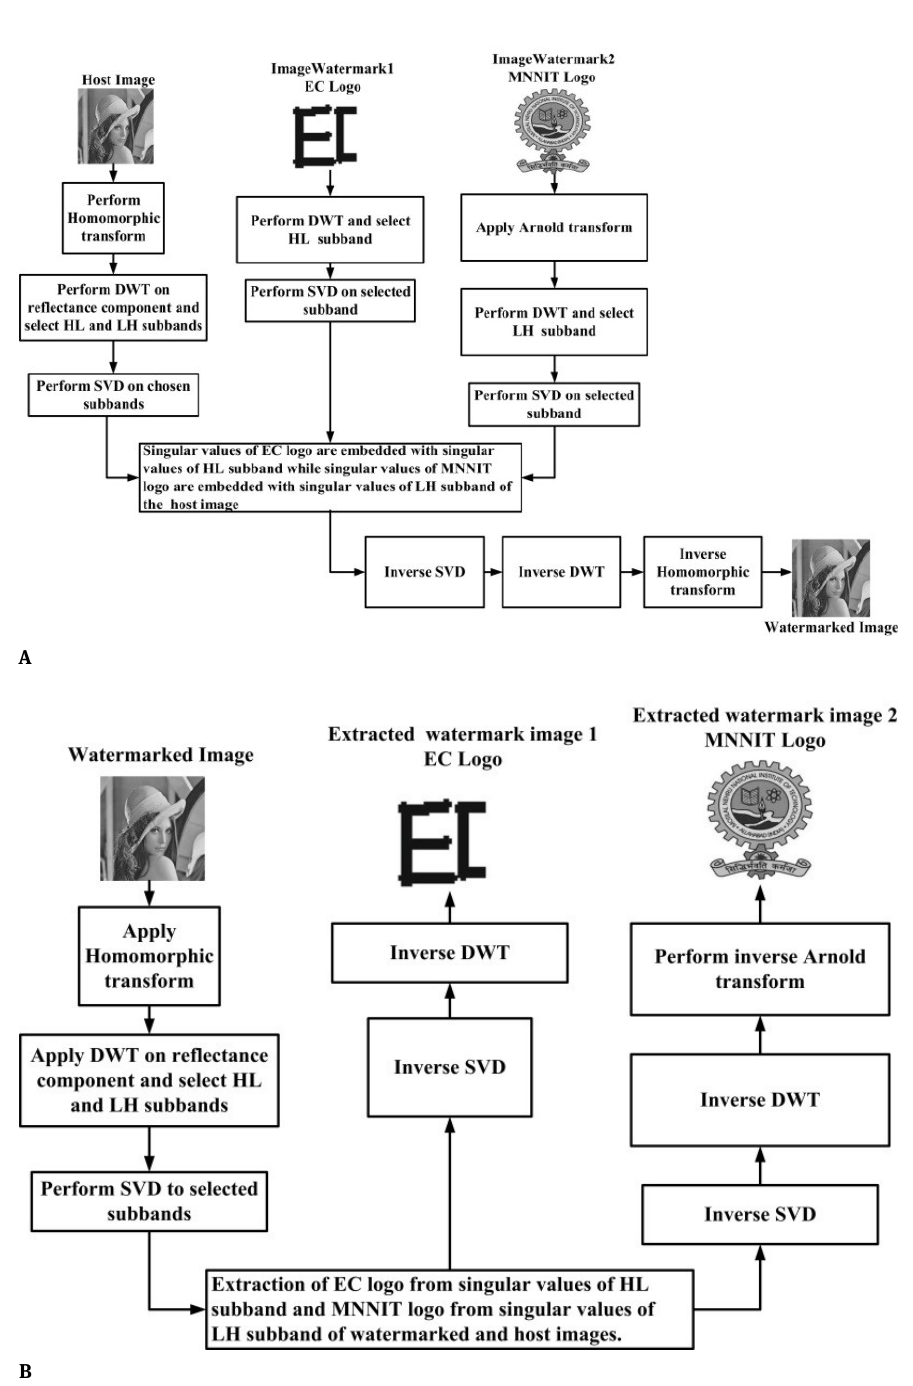
Figure 2: (A) Embedding Algorithm (B) Extraction